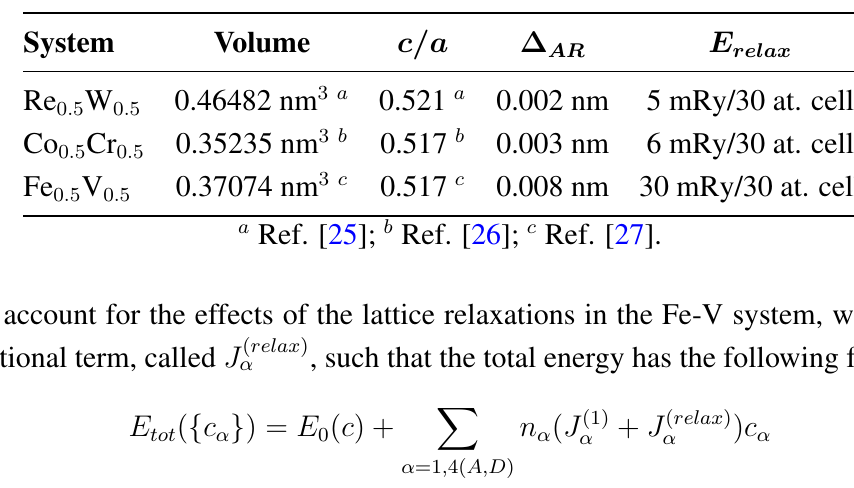
Table 1. The room temperature lattice parameters ( V, c/a ), the corresponding size (atomic radii) mismatch of the alloy components ∆ and the energy of the local atomic relaxations AR E σ in the Re W , Co Cr and Fe V relax 0 . 5 0 . 5 0 . 5 0 . 5 0 . 5 0 . 5